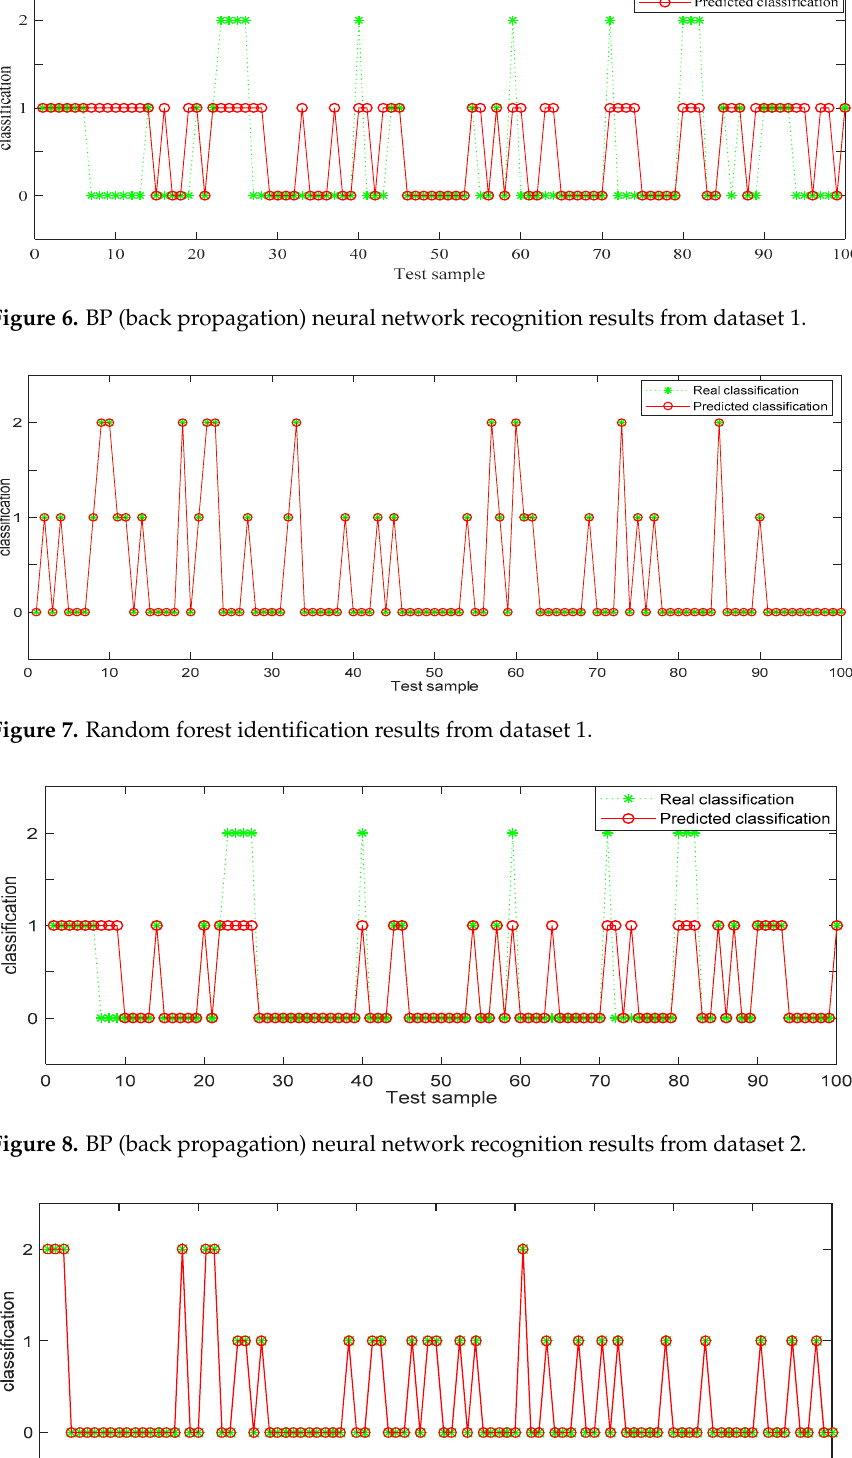
Figure 10. BP (back propagation) neural network recognition results from dataset 3. Figure 11. Random forest identification results from dataset 3. In the three datasets, most of the users who made comments are low-risk users, while only a small number of users are high-risk users, which is also consistent with the data characteristics in Section 4.3 above. In the 100 test samples of Figures 6 – 11, the category of users identified by random forest is consistent with the real category, but the recognition results from BP (back propagation) neural network are only partially accurate. This suggests that the random forest identification method has higher accuracy and feasibility, which can be used for identifying high-risk users in public opinion discussions of an enterprise network. 4.7. Discussion User portrait technology and the random forest algorithm were used to monitor and identify the public opinion events related to “Hive Box charges”. The related discussions are as follows: (1) When the sample size is big enough, the results of training indicate a dependence of precision on the training sample size. However, if the sample size is small, the result